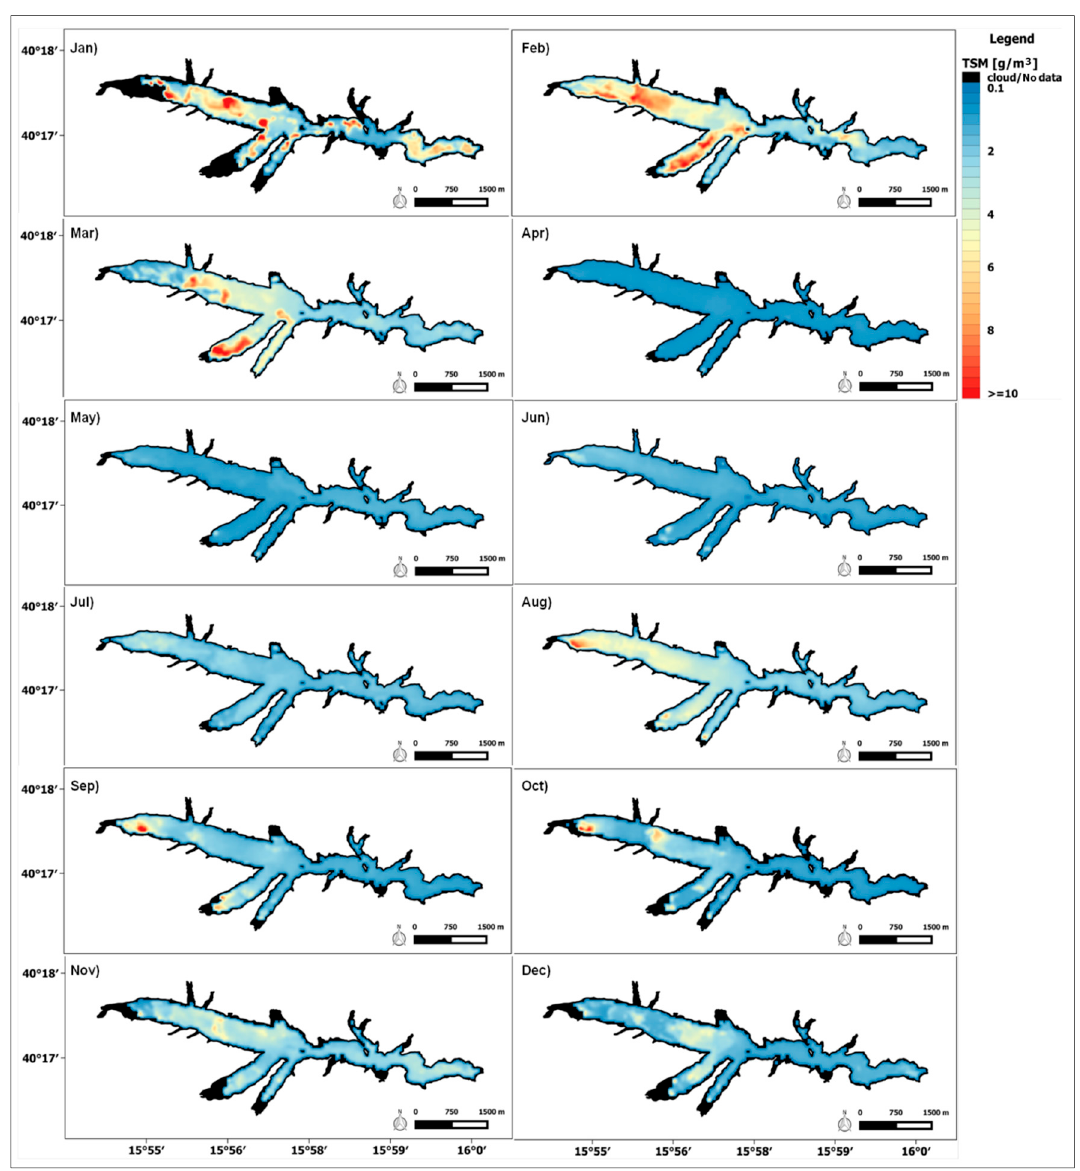
Figure 9. The multi-year (2014–2018) TSM monthly averaged maps for each calendar month. Black Figure9. Themulti-year(2014–2018)TSMmonthlyaveragedmapsforeachcalendarmonth. Blackpixels pixels correspond to non-water, cloudy, or missed data. correspond to non-water, cloudy, or missed